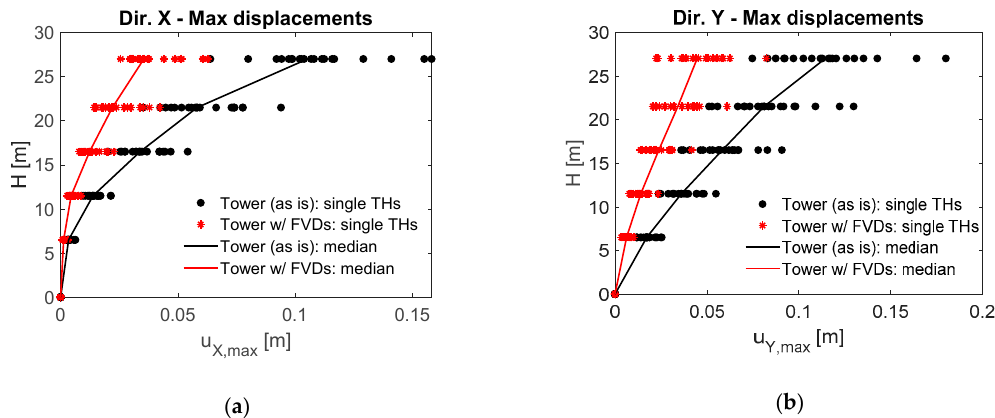
Figure 22. Maximum displacements along the height of the tower, before and after retrofitting: ( a ) X direction; and ( b ) Y direction.